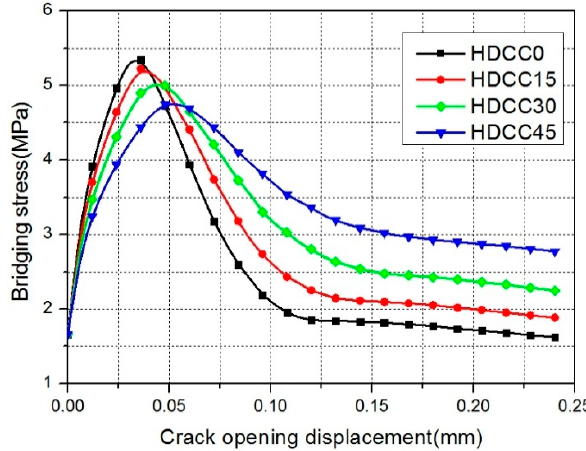
Figure 6. Bridging stress-crack opening displacement relationship of HDCCs.